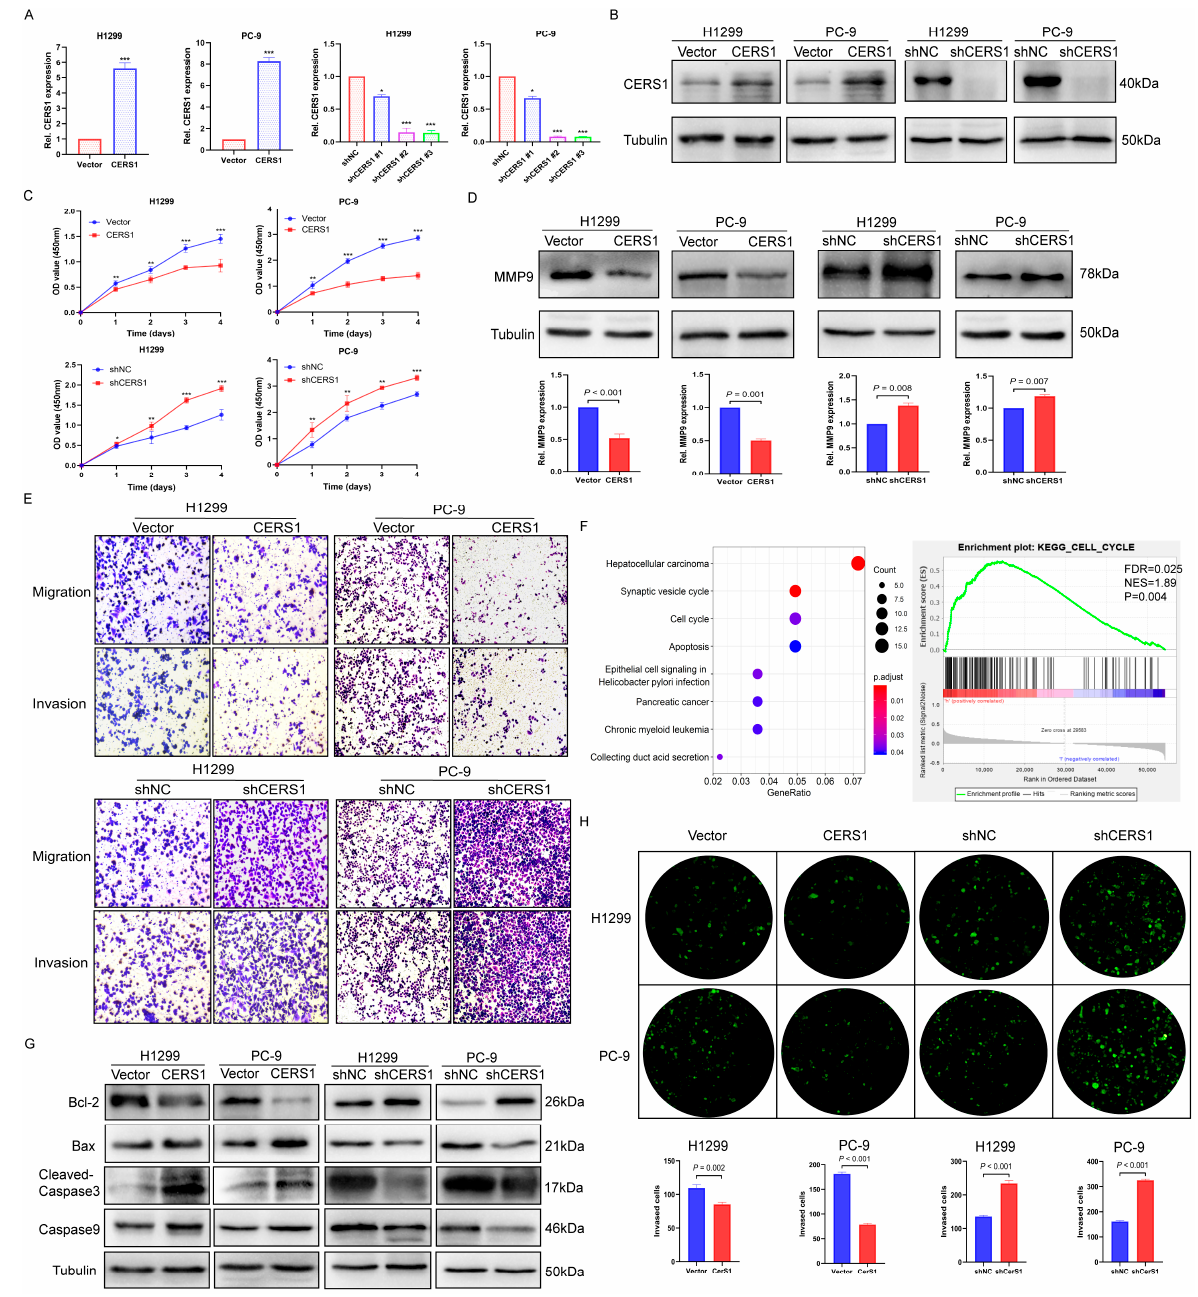
Figure 2. CERS1 overexpression inhibits the proliferation, migration, and invasion of NSCLC cells. ( A , B ) The efficiency of CERS1 overexpression and depletion was analyzed using RT-qPCR and western blotting. ( C ) The ability of H1299 and PC-9 cells to proliferate following CERS1 transfection was tested using CCK-8 assays. ( D ) MMP-9 expression was evaluated using western blotting. ( E ) The ability of H1299 and PC-9 cells to migrate and invade was tested through transwell assays. ( F ) KEGG and GSEA analyses were used to determine the signaling pathway associated with CERS1. ( G ) The impact of CERS1 on cell apoptosis was detected using western blotting. ( H ) Effect of CERS1 on the ability of lung cancer cells to penetrate the BBB model. * p < 0.05; ** p < 0.01; *** p < 0.001. KEGG and GSEA enrichment analyses showed that CERS1 was closely associated with the cell cycle and apoptosis ( p < 0.05, Figure 2F). Using Annexin V-APC, Western blotting, and cell cycle assays, we found that CERS1 overexpression increased the proportion of apoptotic cells and enhanced the expression of apoptosis-related proteins, including